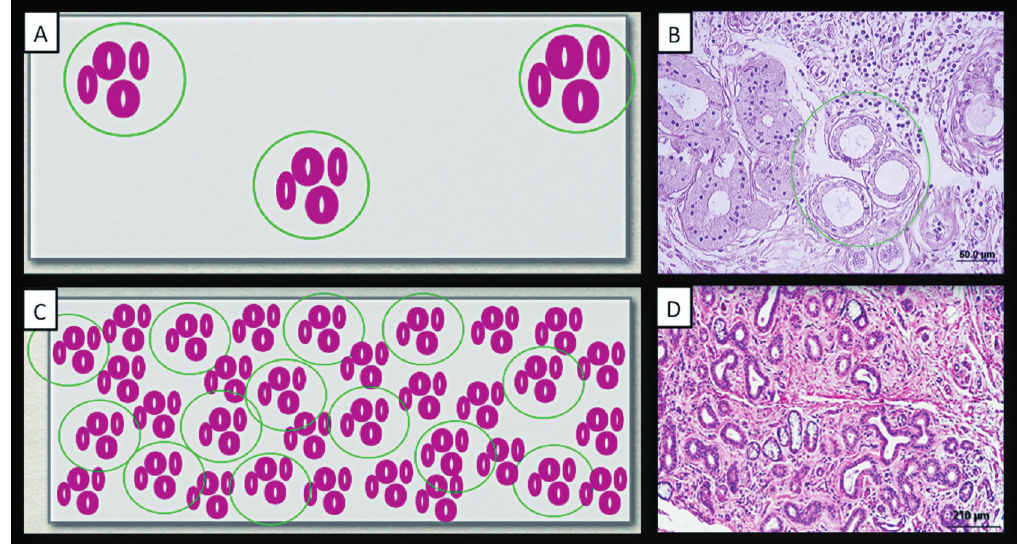
Figure 2- Schematic representation of the selection of spots. A: Due to the small quantity of duct-like structures (DLS) in group I, all microscopic fields containing DLS were captured; B: A spot containing three DLS; C: 20 fields containing DLS were randomly captured in group II; D: Diffuse distribution of DLS in group